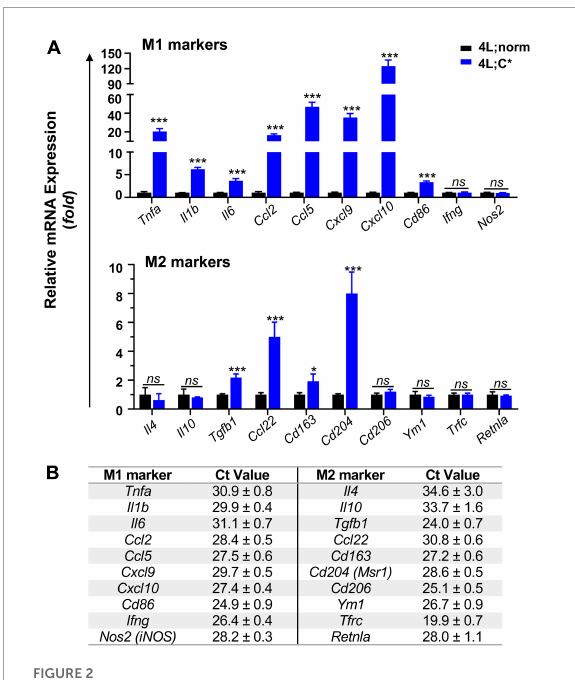
FIGURE2 Relative mRNA expression and abundance of selected M1/M2 makers in the brain of mice harvested at ∼ 55 days of age. Middle brain part (cerebrum without cortex and brain stem) was used for mRNA isolation and RT-qPCR analysis using 5 ng mRNA. (A) Expression levels of main M1 and M2 markers are shown with Tbp used as internal reference gene. Data are presented as mean ± SEM, n = 4. * p ≤ 0.05; *** p ≤ 0.001; ns, non-significant by Student’s t -test analysis. (B) Baseline Ct values of M1/M2 markers in 4L;norm control samples, showing relative mRNA abundance (with Tbp as 22.2 ± 0.3). Data are presented as mean ±